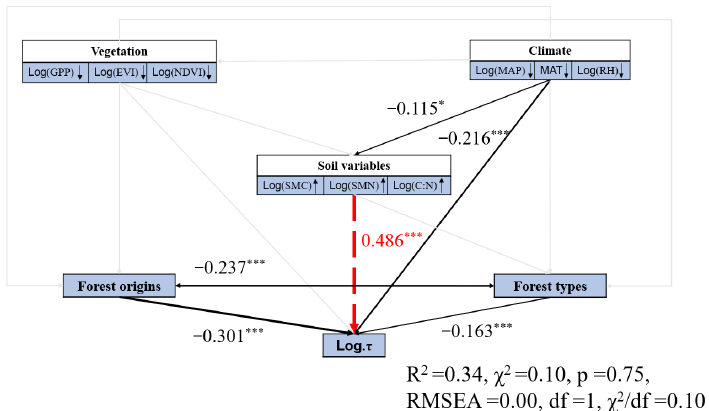
Figure A7. The main influencing factors of C turnover in the subsoil of the subtropical zone were obtained by the SEM model. The symbols “ ↑ ” and “ ↓ ” indicate a positive or negative correlation between environmental factors and subsoil τ . The goodness of fit statistics for the effect size model of the relationship are as follows: * p < 0.05, *** p < 0.001.